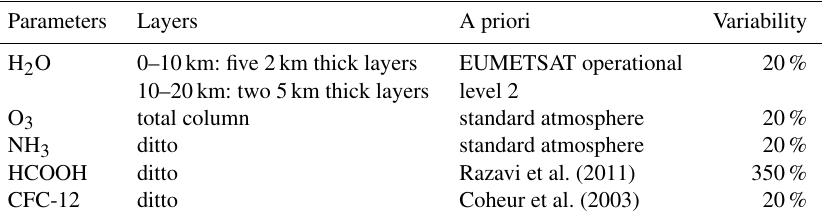
Table 2. Retrieval parameters used in this